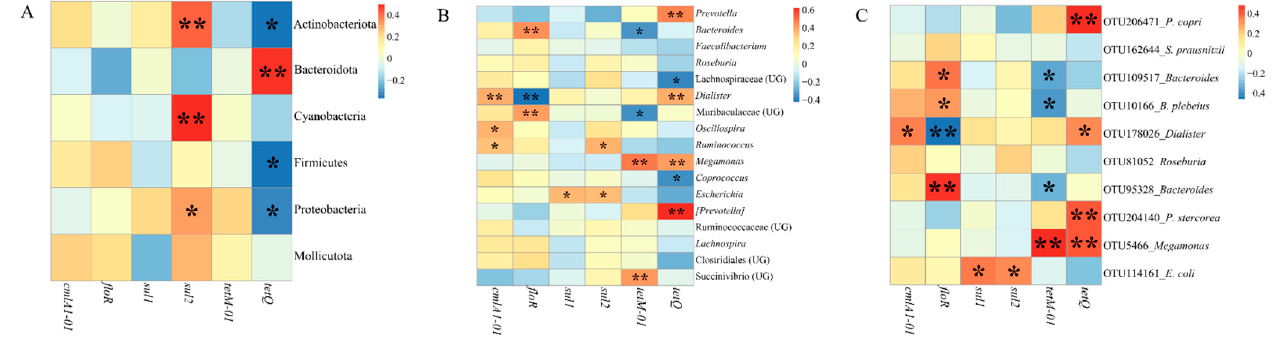
Figure 7. The correlations between gut microbiomes and ARGs at phylum ( A ), genus ( B ) and OTU level ( C ). * p < 0.05; ** p < 0.01.